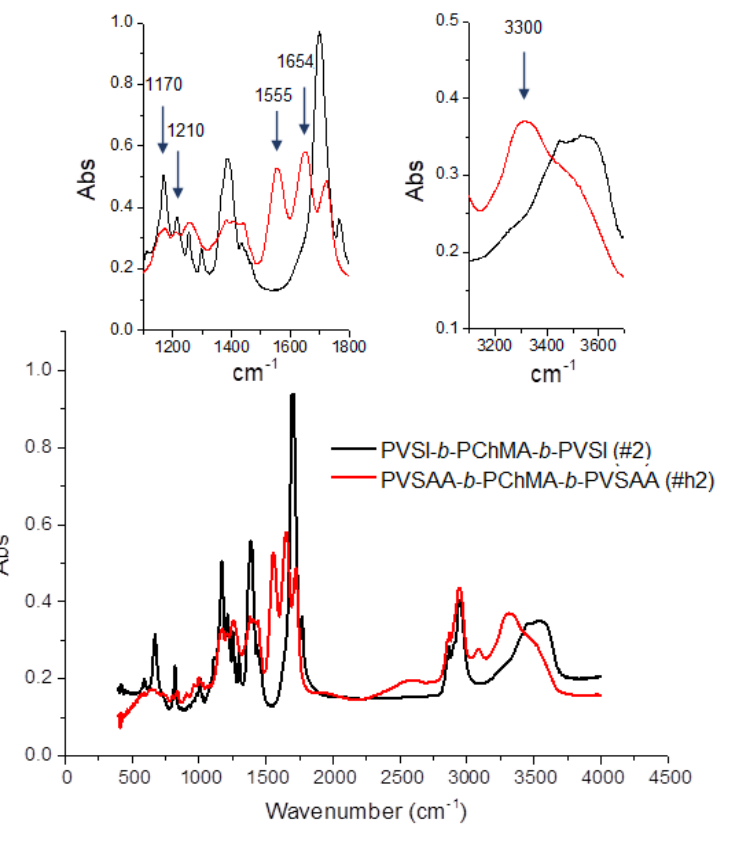
Figure 5. FTIR spectra of PVSI- b -PChMA- b -PVSI and PVSAA- b -PChMA- b -PVSAA.